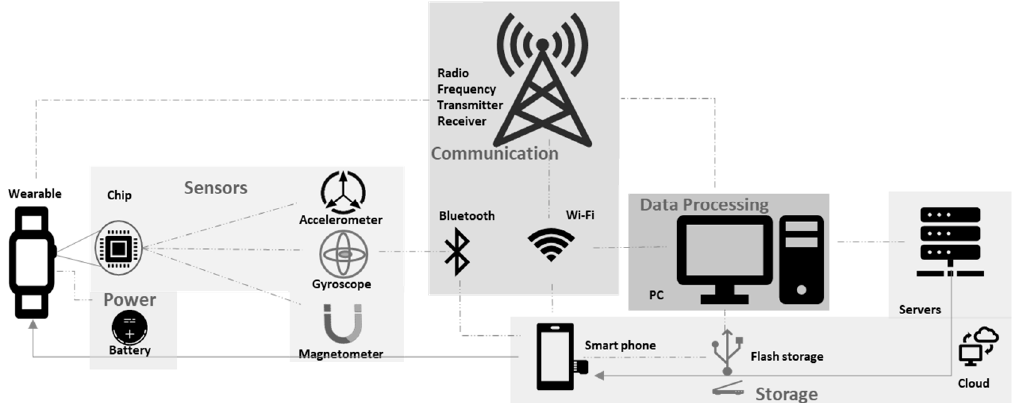
Figure 7. Block diagram example of wearable technology framework.